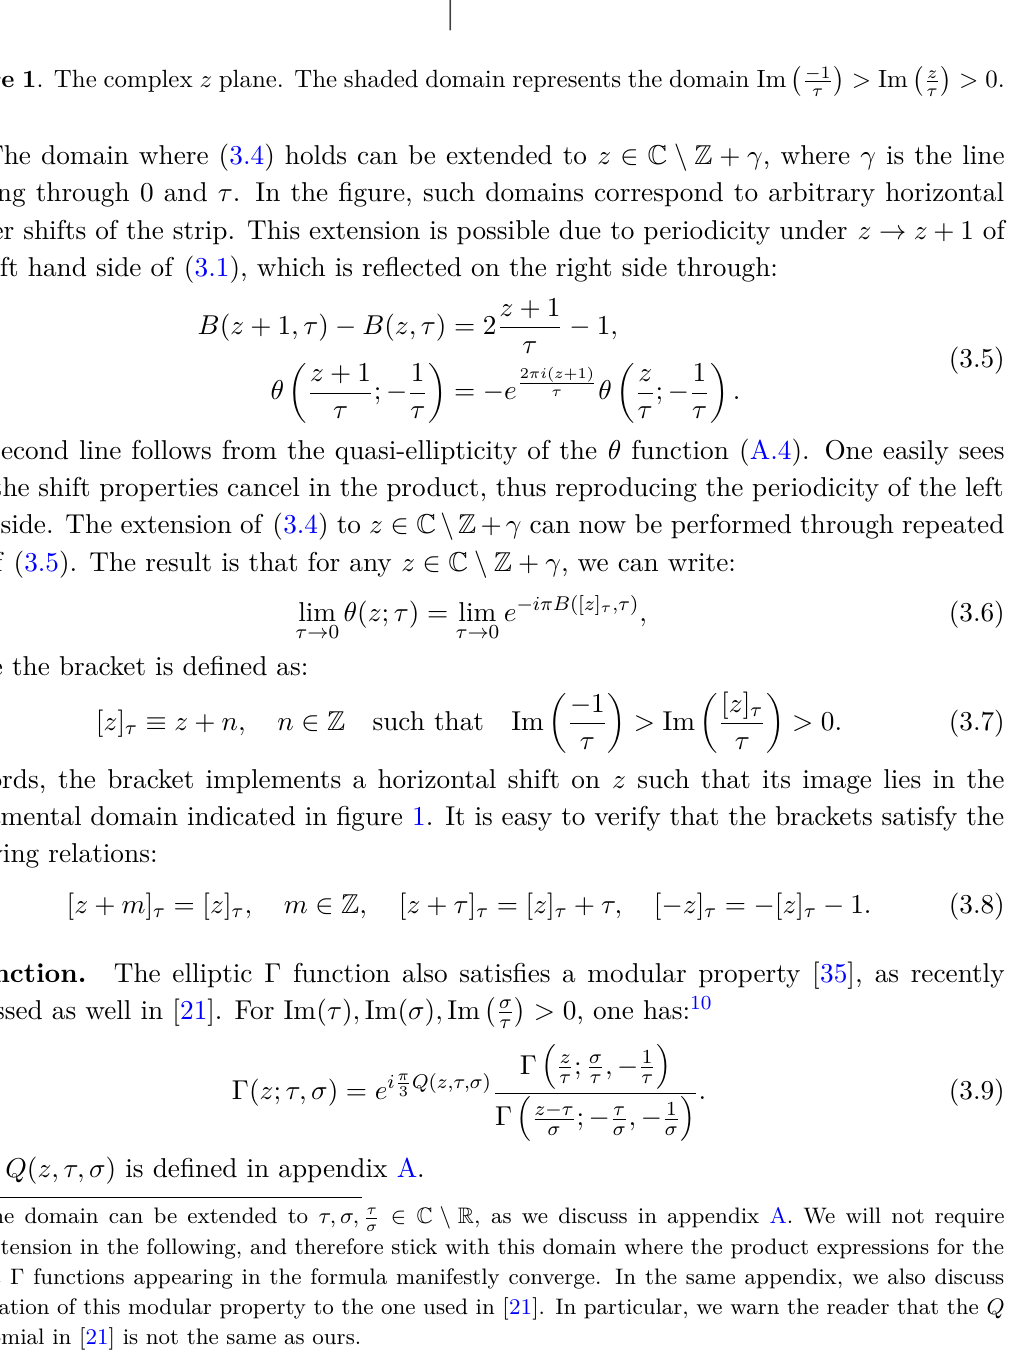
Figure 1 . The complex z plane. The shaded domain represents the domain Im